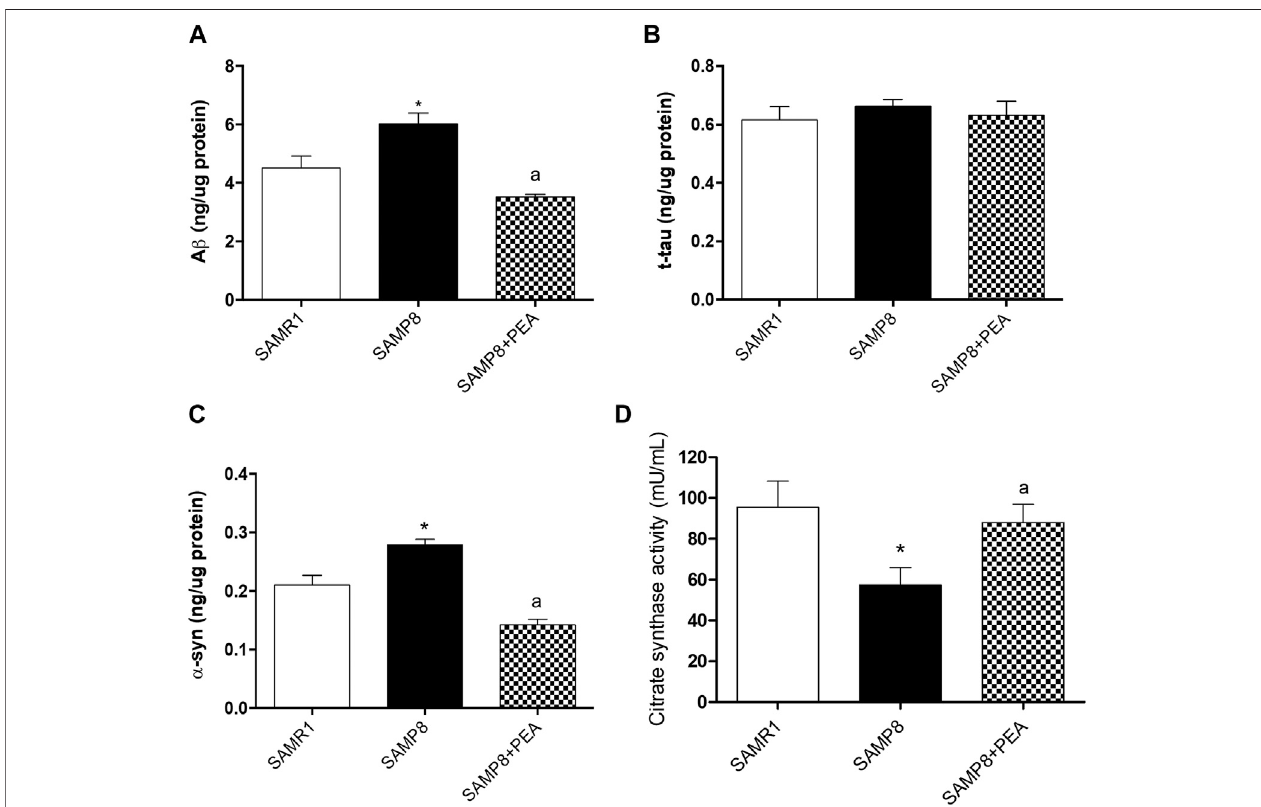
FIGURE 3 | PEA counteracts the accumulation of NDs-related proteins and restores the citrate synthase activity in colonic tissues from SAMR1, SAMP8 and SAMP8 treated with PEA. Quanti fi cation of NDs-related proteins: (A) A β , (B) t-tau, and (C) α -syn concentrations were assessed by a “ home-made ” ELISA assay. Each columnrepresentsthemean ± SEM.fromthreeanimals. (D) citratesynthaseactivityincolonictissuesfromSAMR1,SAMP8andSAMP8treatedwithPEAanimals.Each columnrepresentsthemean ± SEM.fromfouranimals.One-wayANOVAfollowedbyTukeyposthoctestresults:* p < 0.05,signi fi cantdifferencevs.SAMR1and a p < 0.05,signi fi cantdifferencevs.SAMP8.; Abbreviations :A β ,amyloid β 1-42; α -syn, α -synuclein;ELISA,enzyme-linkedimmunosorbentassay;NDs,neurodegenerative disorders; PEA, palmitoylethanolamide; t-tau, total